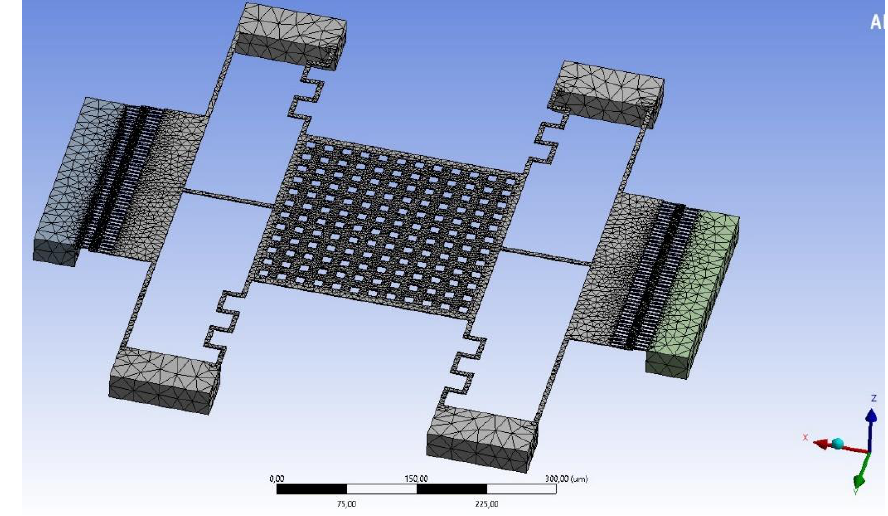
Fig. 5. Finite element meshes parametric 3D model MEMS